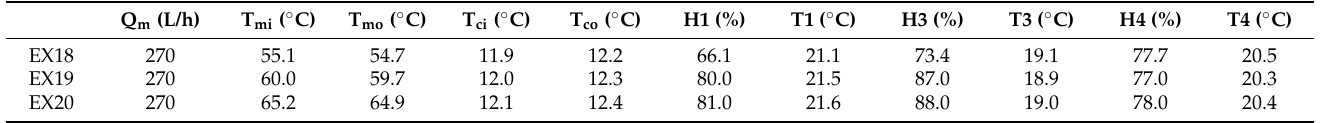
Table 10. Measured temperatures and humidity for